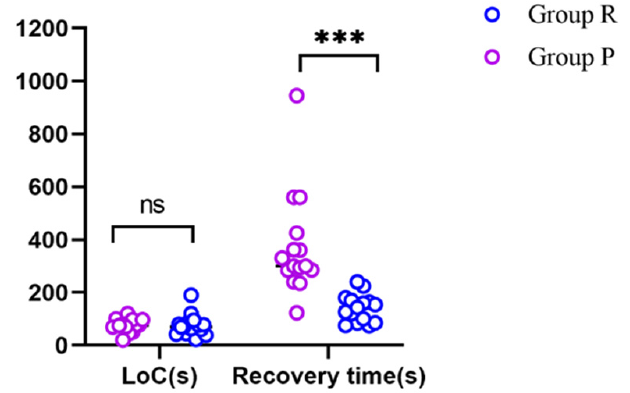
Figure 3. The LoC values and recovery times of the two groups. *** p < 0.001; ns: not significantly different; LoC: loss of consciousness.